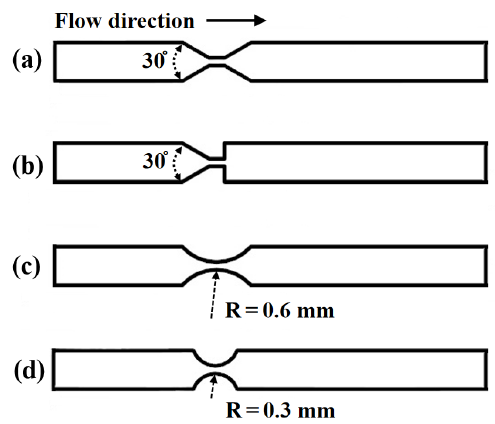
Figure 9. The orifice structures, ( a ) converging-diverging orifice, ( b ) converging orifice, ( c ) curved orifice ( R = 0.6 mm), and ( d ) curved orifice ( R = 0.3 mm).